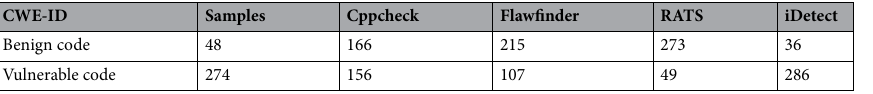
Table 3. The binary classification evaluation results of the three SATs and iDetect on the TinyOS evaluation